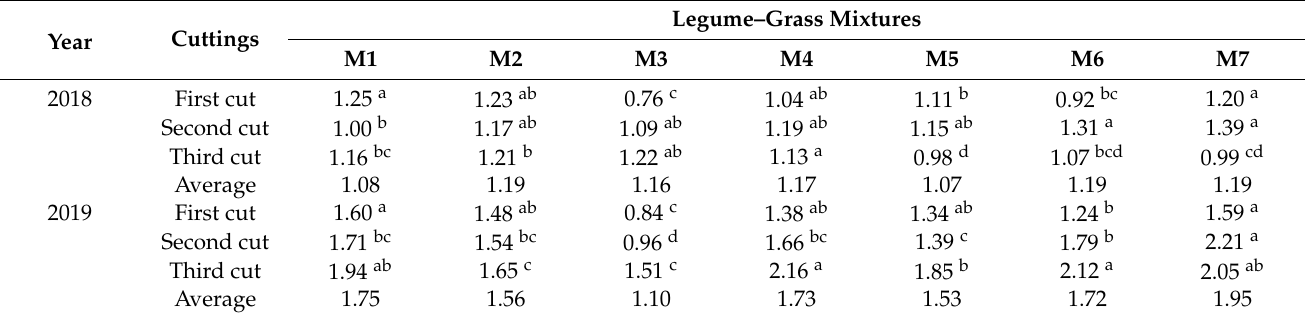
Table 5. Land-equivalent ratio values of legume–grass mixtures at different cuts for the establishment years 2018 and